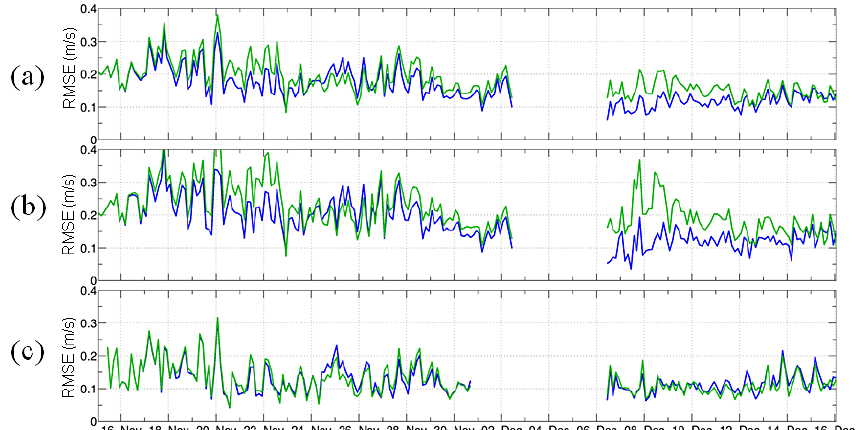
Figure 13. Temporal evolution of (a) Er a , b (y) , (b) Er a , b (y pey ) , and (c) Er a , b (y ben ) for ObcReal . Er b (Er a ) is in green (blue).